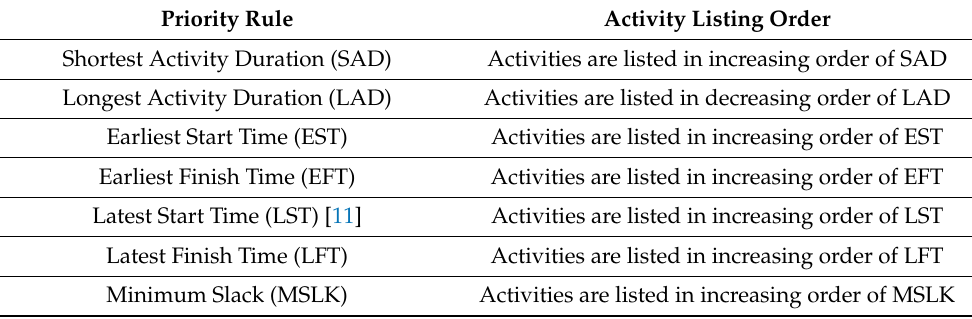
Table 1. Priority rules frequently